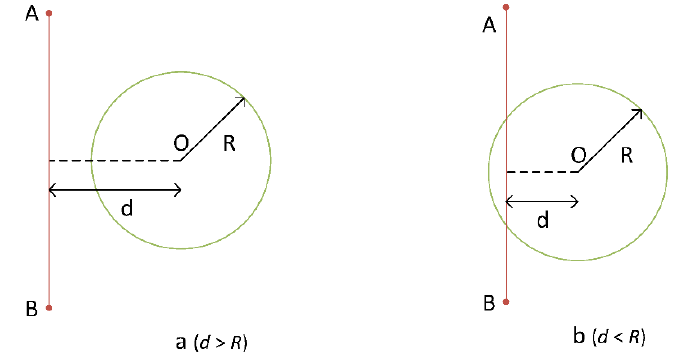
Figure 5. Diagram of the Intersection Detection of a Line Segment and a Sphere.